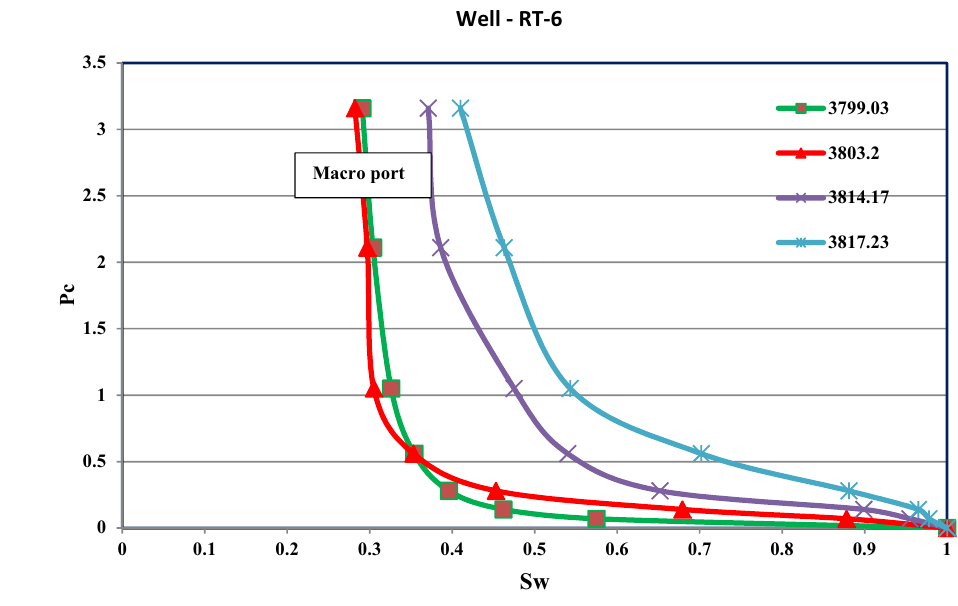
Table 1 Pore-throat size (R35) and pore type for well Rt-3 Unit